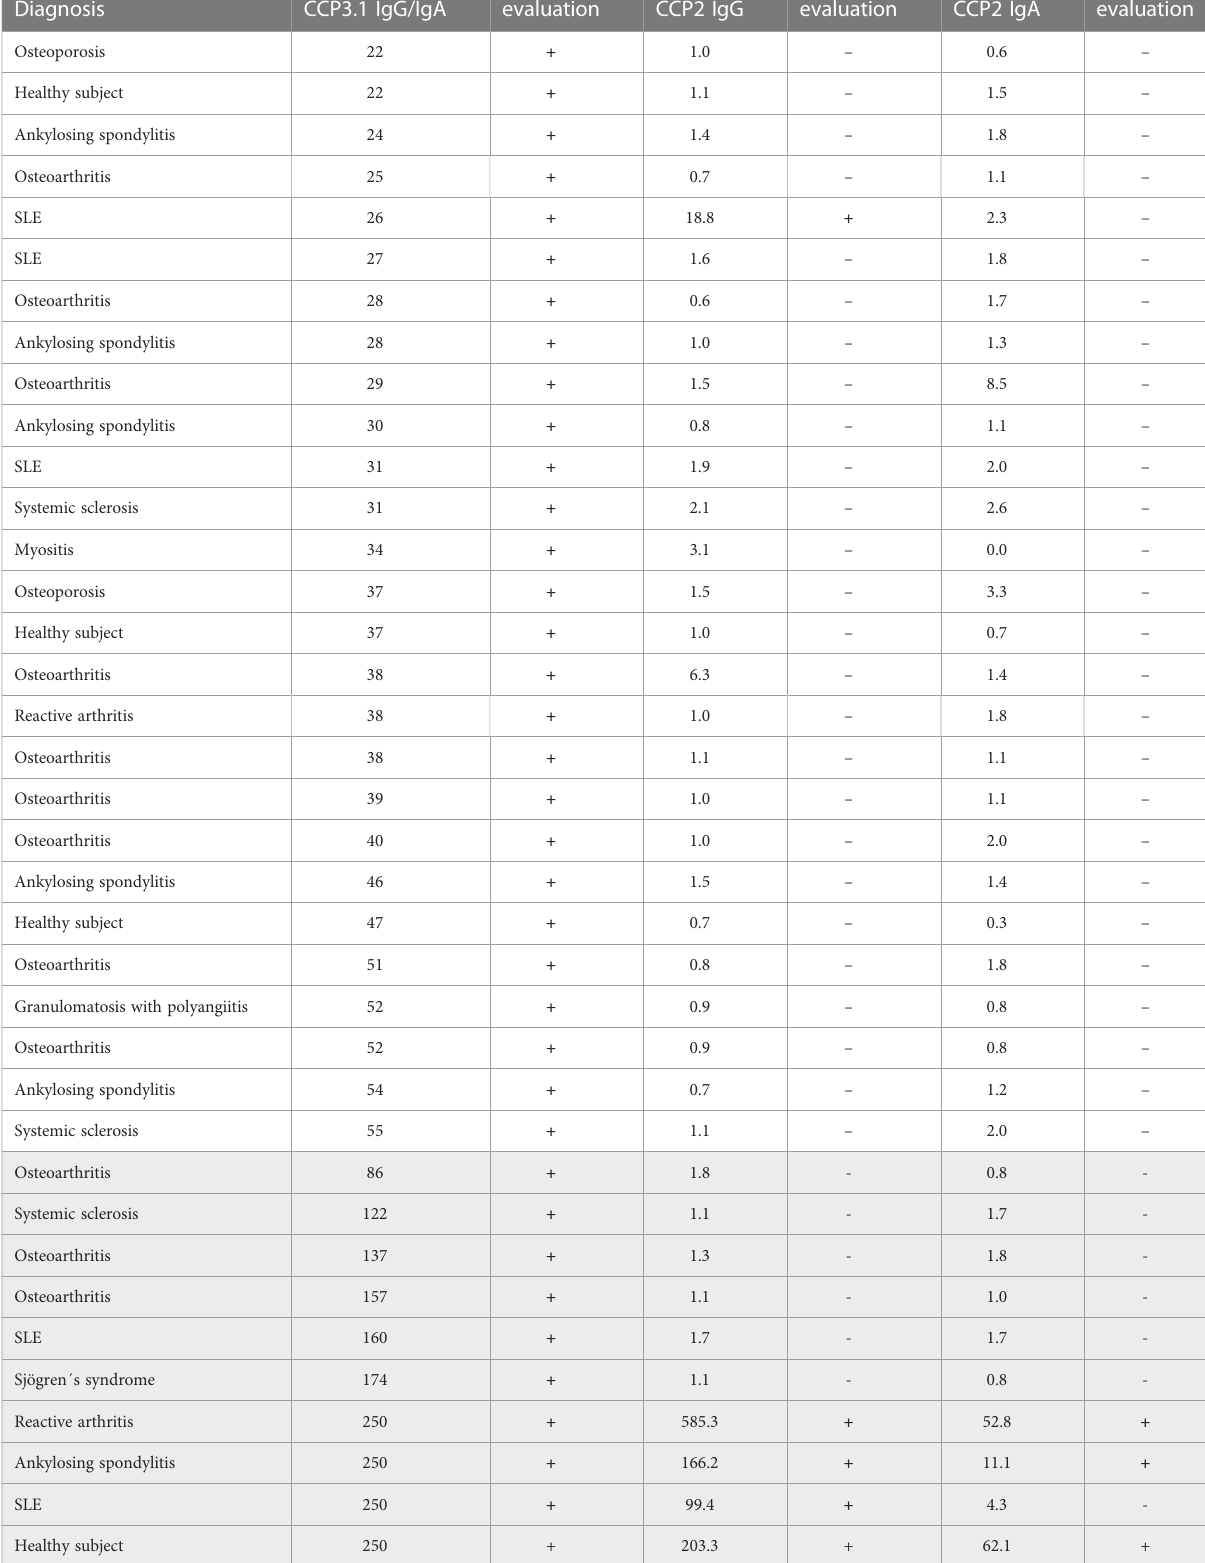
Rows marked in grey identify those disease controls which would still be positive in the anti-CCP3.1 assay when the high positive (60 AU/ml) cut-off is